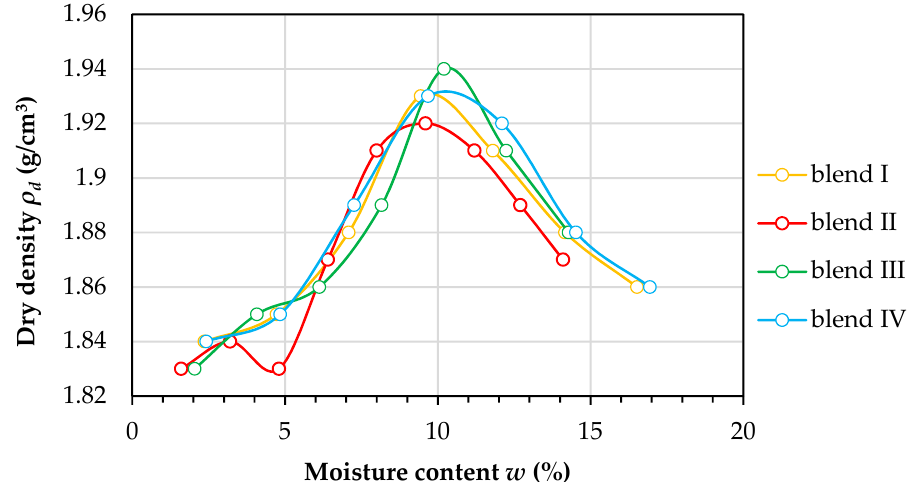
Figure 2. Results of the Proctor tests for RCA blends with an energy density of compaction Ec equal to 0.59 J/cm 3 .